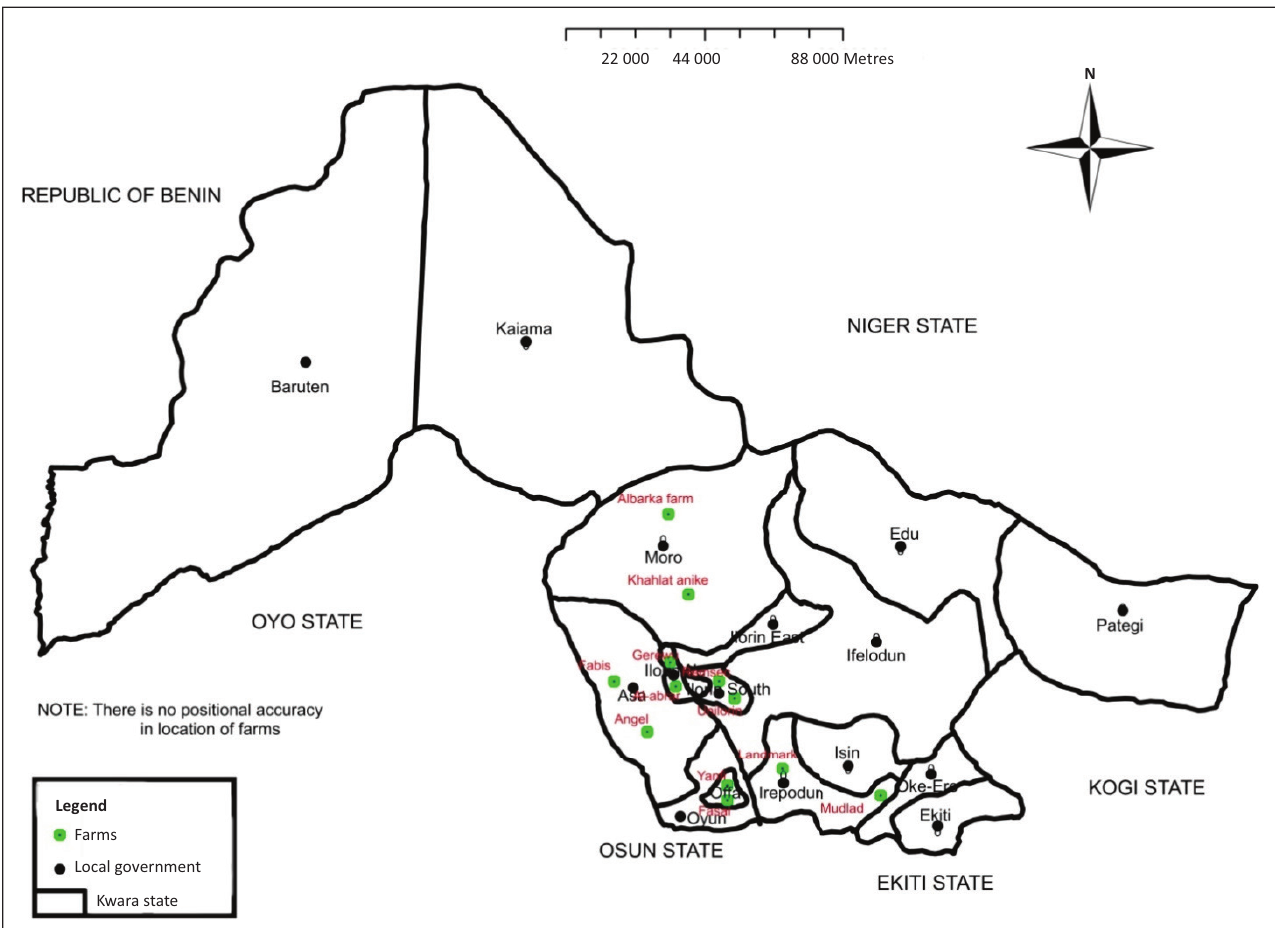
FIGURE 1: A map of Kwara State showing locations of the sampling sites within selected local government